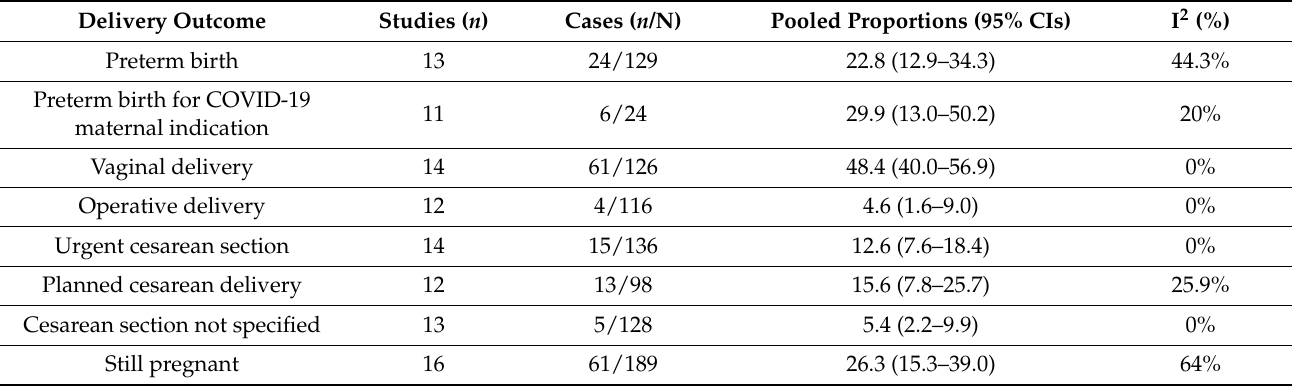
Table 5. Delivery outcomes expressed as mean ± standard deviation (SD) or in terms of pooled proportions with their 95% confidence intervals (CIs).